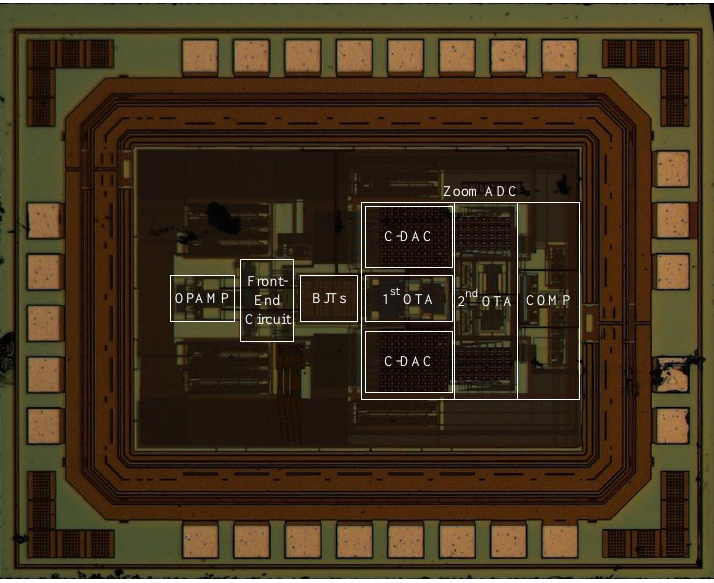
Figure 7. Chip micrograph. (Note: OTA: operational transconductance amplifier; C-DAC: capacitive digital-to-analog converter; COMP: comparator).